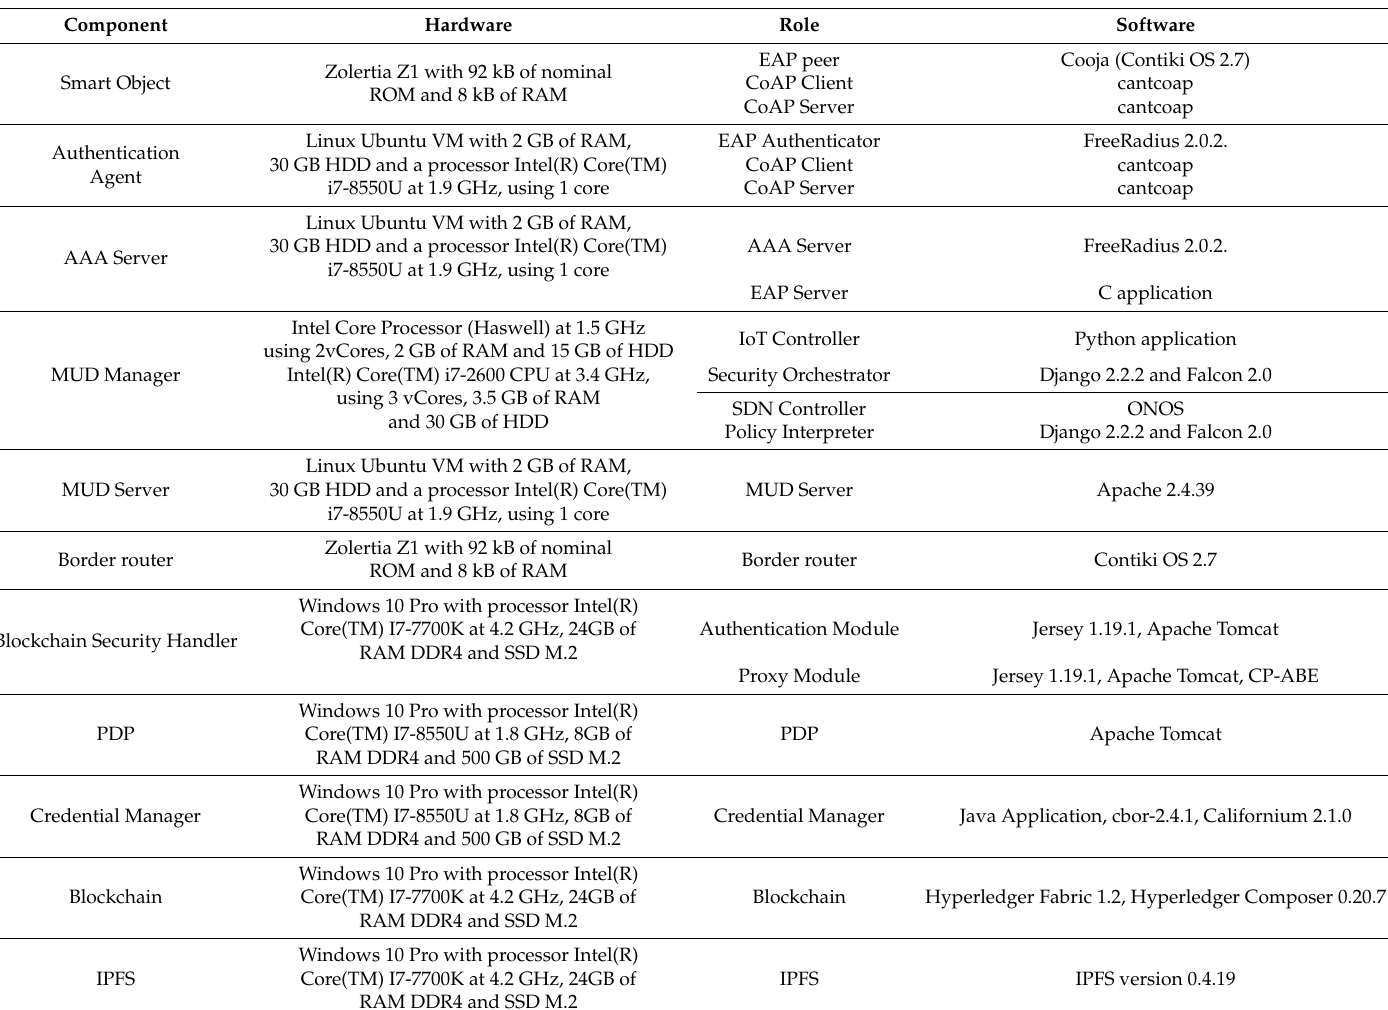
Table 3. Testbed